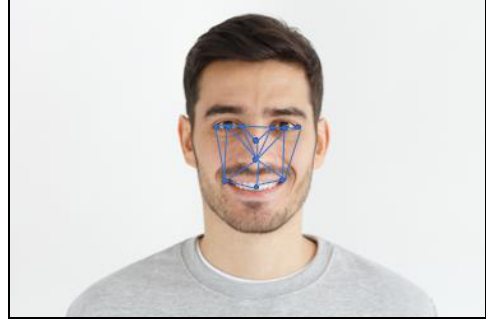
Figure 9. Selected Features in [18].